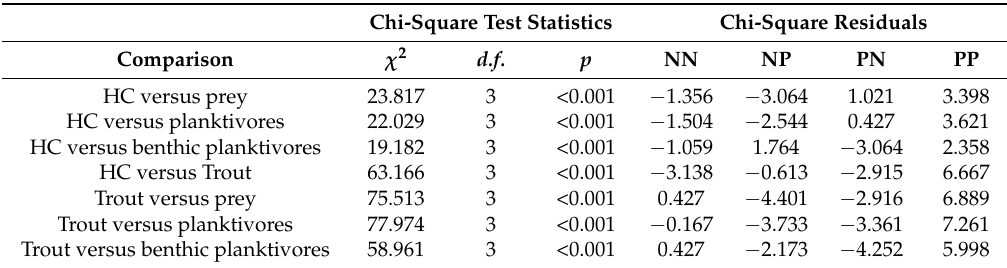
Table 3. The relative influences of top-down control by coral trout and availability of coral habitat (using hard coral cover (HC) as a proxy) on planktivorous damselfish of the Great Barrier Reef. Data are Chi-squared test statistics ( χ 2 ), degrees of freedom ( d.f. ) and residuals associated with each comparison of temporal trajectories in abundance and hard coral cover: NN negative/negative; NP negative/positive; PN positive/negative; PP positive/positive. No pattern is indicated where residuals = 1. Negative residuals indicate that there were fewer responses than expected while positive residuals indicate there were more responses than